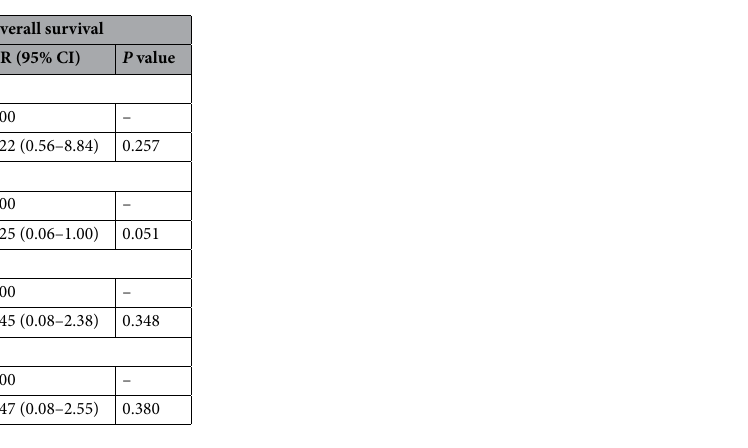
Table 9. Multivariate analysis of metastasis-free survival in osteosarcoma patients and IMPDH2/HPRT ratio in post-chemotherapy tissues (n =